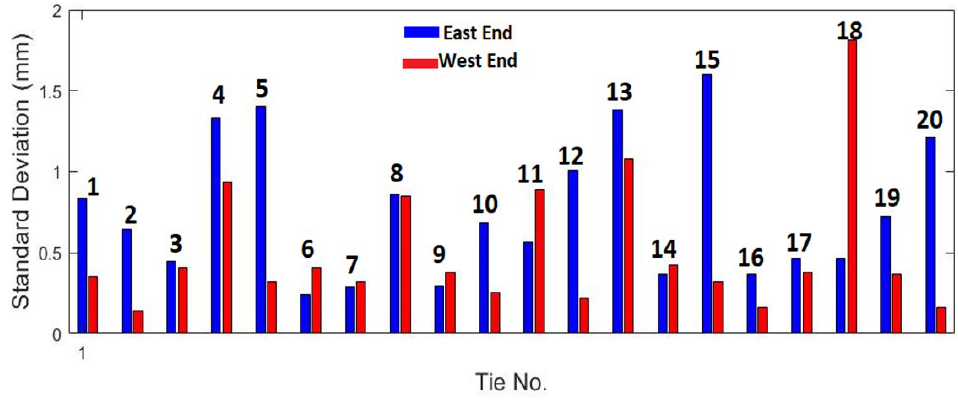
Figure 21. Standard deviation of tie end deflections of the first 20 ties computed over four test